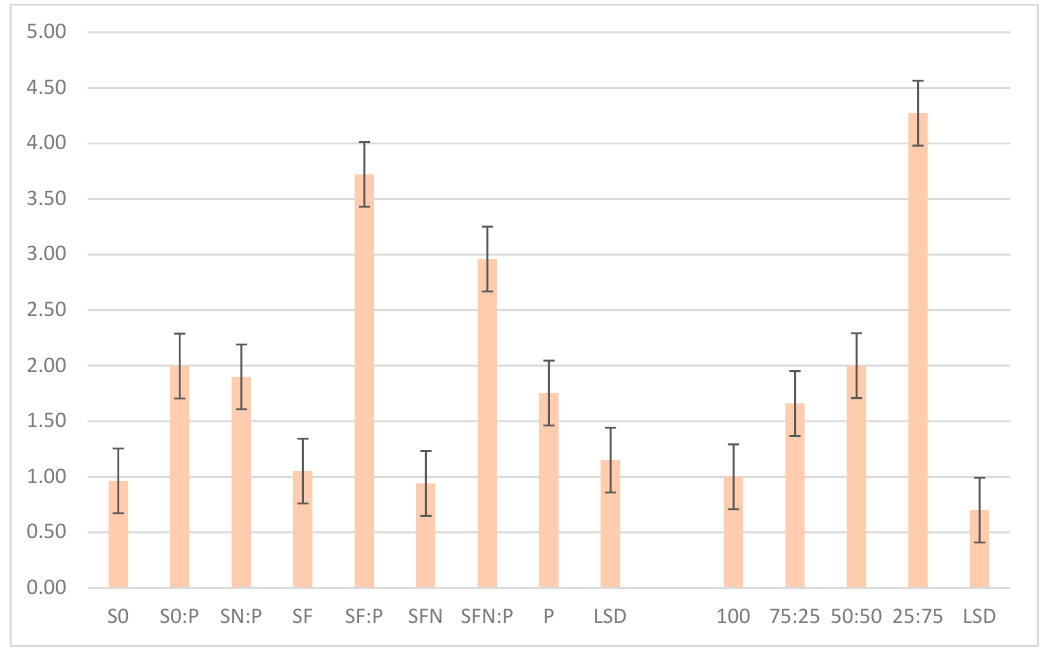
Figure 1. The effects of different media and volumetric media proportion on tomato transplant mass (in g).